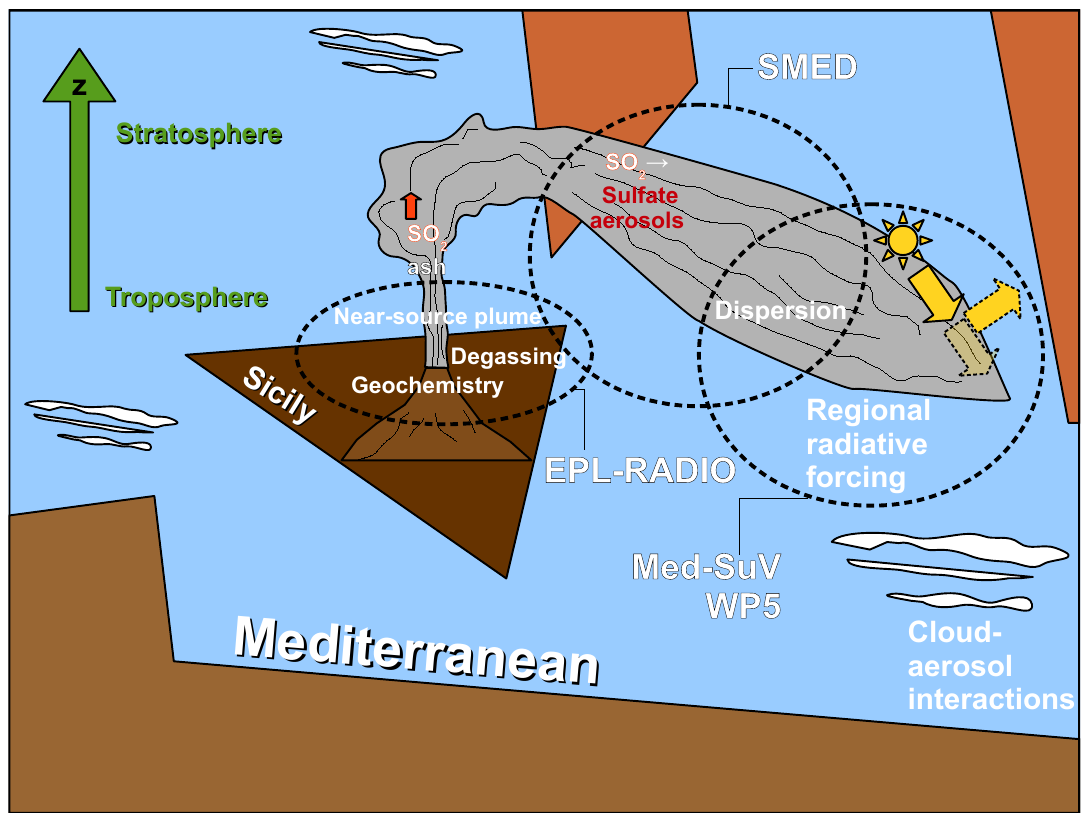
Figure 1: Spatial extents and interactions of the three modules establishing the EPL reserch